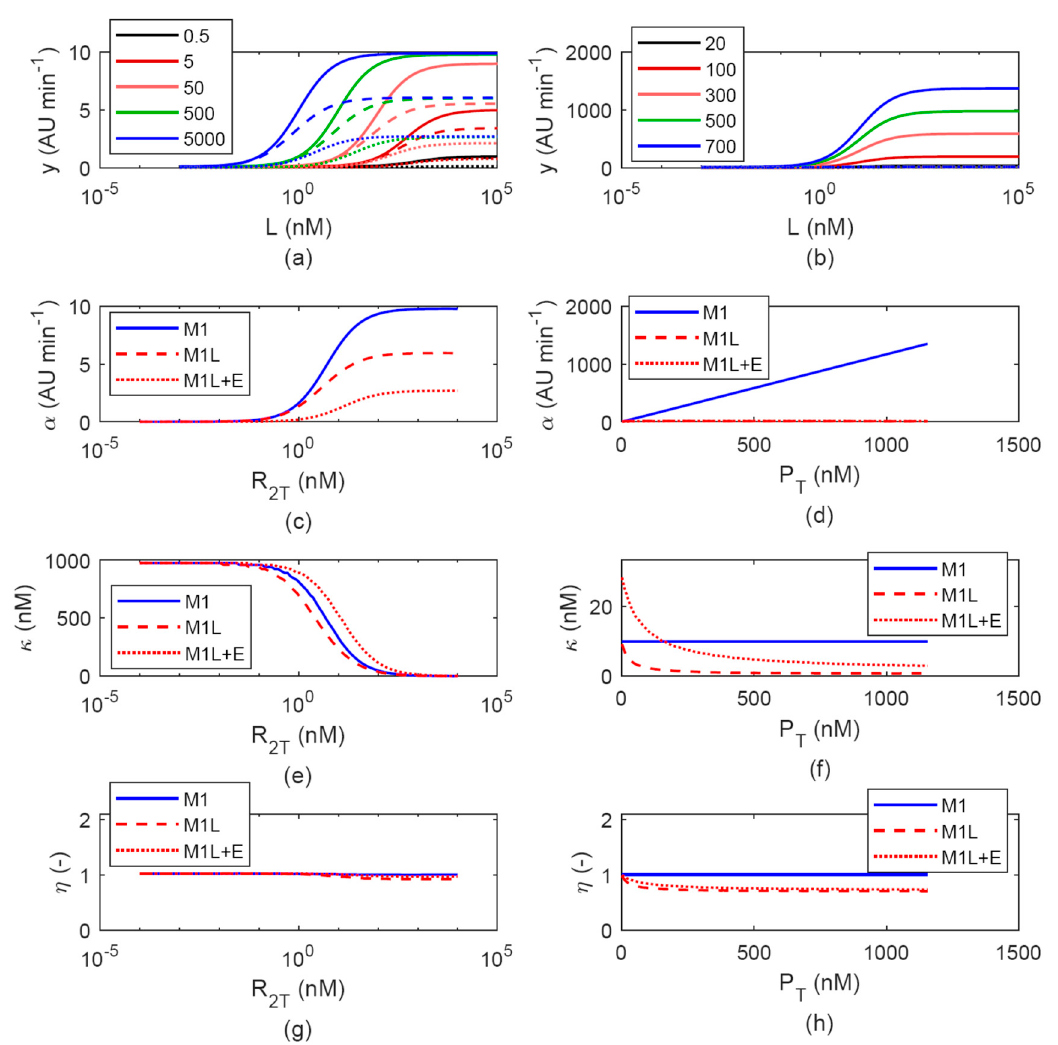
Figure 3. Comparison between M1 and M1L. Panels ( a , b ) report the output activation curves of M1 (solid lines) and M1L (dashed lines) and M1L with external load, indicated as M1L+E (dotted lines), for different values of R 2T (panel ( a ), as indicated in the legend, expressed as nM) and P T (panel ( b ), as indicated in the legend, expressed as per cell copy number). The ( c )–( d ), ( e )–( f ), and ( g )–( h ) panel pairs report the R 2T - and P T -dependent trend of α , κ and η , respectively, with solid, dashed, and dotted lines representing M1, M1L, and M1L+E, respectively. In panels ( a , c , e , g ) the promoter copy number value was set to 5, while in panels ( b , d , f , h ) the LuxR concentration was set to 500 nM.